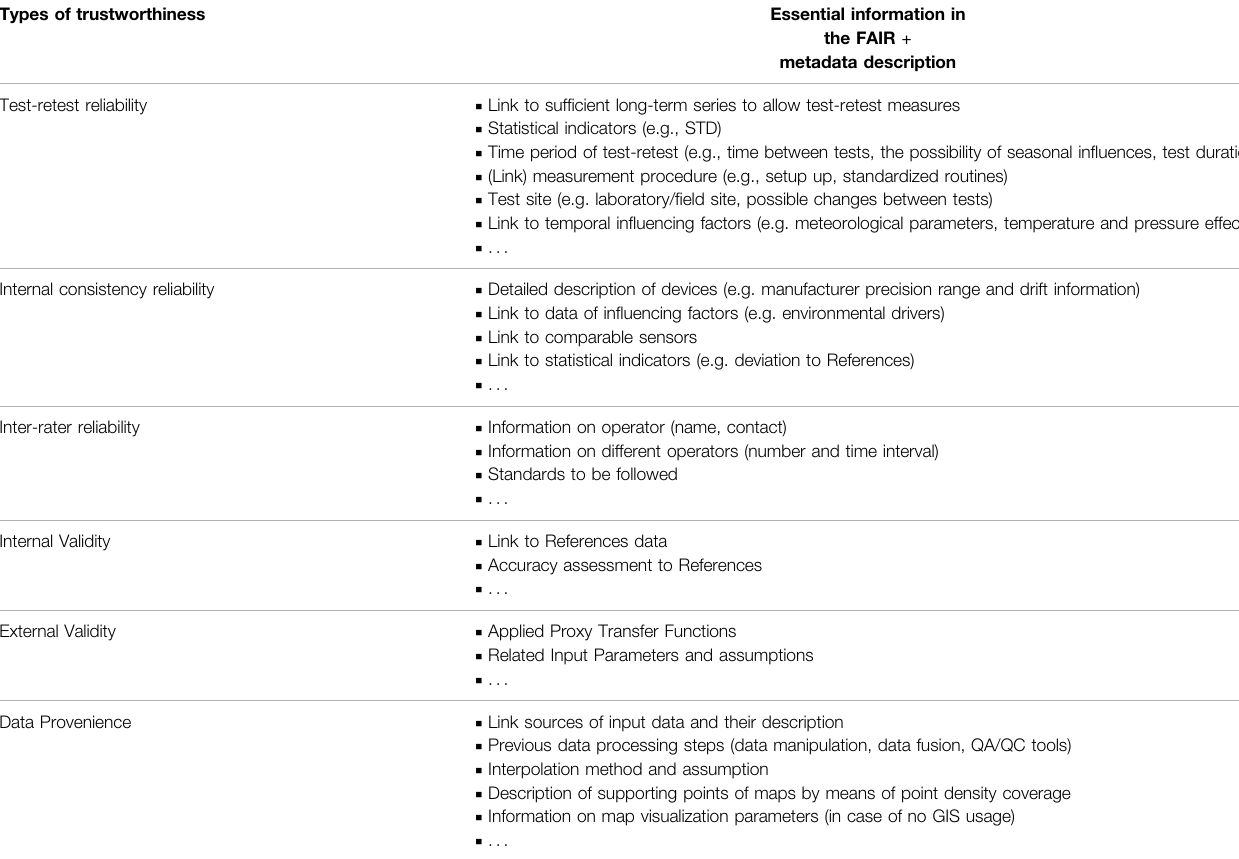
TABLE 2 | Summary of essential information in the FAIR + metadata description for the above-discussed data trustworthiness issues. This table should be seen as a fi rst attempt and a basis for further